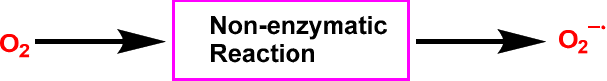
Figure 15. Reactions catalysed by xanthine oxidase.